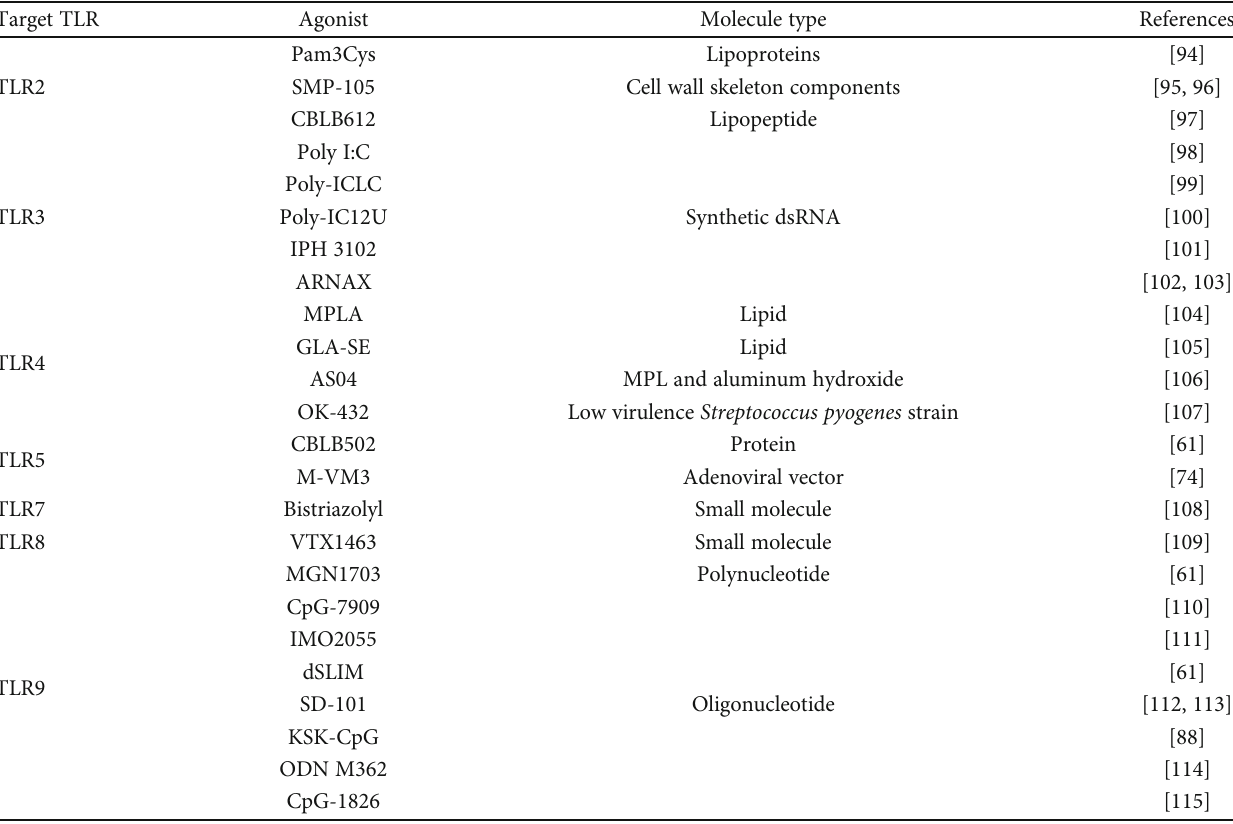
Table 1: A summary of TLR agonists with their corresponding TLR